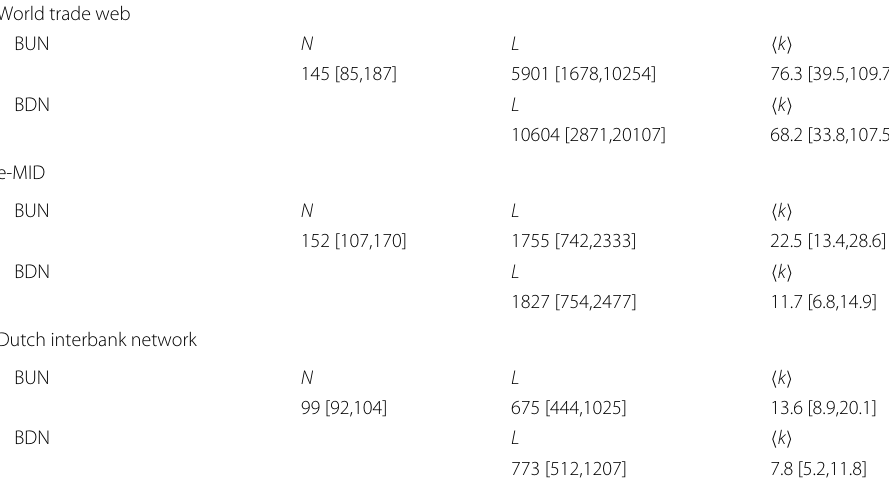
Table 1 Network statistics for both the undirected (BUN) and directed (BDN) version of the World Trade Web, e-MID and the Dutch Interbank Network: for each quantity (number of nodes N , number of links L and average degree (cid:13) k (cid:14) ) the mean value across the temporal snapshots and the range are reported World trade web